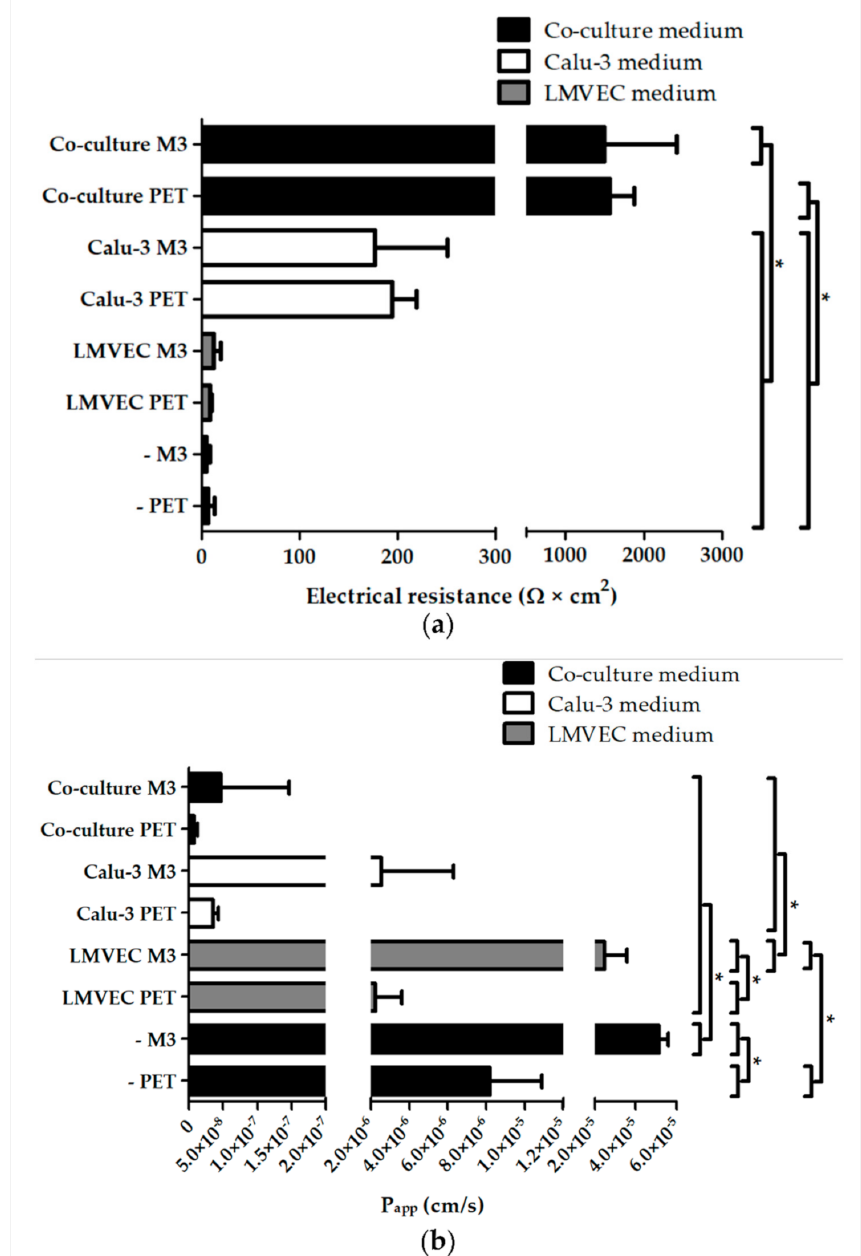
Figure 4. Electrical resistance and P app of fluorescein isothiocyanate-dextran (FITC-dextran) diffusion across co- and mono-cultures of Calu-3 cells and LMVECs on M3 and PET membranes. Calu-3 cells were cultured submerged for 8 days, followed by 2 weeks at ALI. ( a ) Electrical resistance and ( b ) FITC-dextran permeability assays were performed on inserts with M3 or PET membranes containing either no cells, Calu-3 cells, LMVECs, or co-cultures. Capped lines depict significant differences, P < 0.05. Samples originated from two independent experiments (total N ≥ 3 for membranes without cells and N ≥ 7 for samples with cells). The electrical resistance and FITC-dextran permeability of membranes without cells in Calu-3 and LMVEC medium (data not shown) were similar to those of respective samples in co-culture